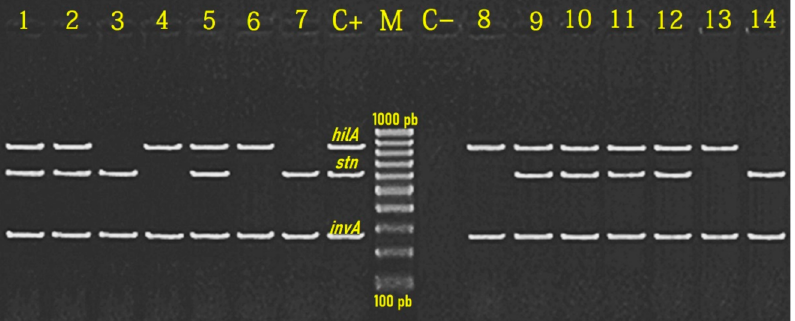
Figure 2. Agarose gel electrophoresis of multiplex PCR amplicons of invA (275 bp), stn (617 bp), and hilA (854 bp) virulence genes of Salmonella spp. Lane M: 100-bp ladder as a molecular size DNA marker (Jena Bioscience GmbH). Lane C+: Control positive strain for invA , stn , and hilA genes. Lane C–: Control negative. Lanes 1 (S. Enteritidis), 2 ( S . Typhimurium), 5 ( S . Infantis), 9 ( S . Dublin), 10 ( S . Anatum), 11 ( S . Derby), and 12 ( S . Papuana) showed positive bands for invA , stn and hilA genes. Lanes 3 (S. Montevideo), 7 ( S . Essen), and 14 ( S . Chester) showed positive bands for invA and stn genes. Lanes 4 ( S . Rissen), 6 ( S . Virchow), 8 ( S . Tsevie), and 13 ( S . Saintpaul) showed positive bands